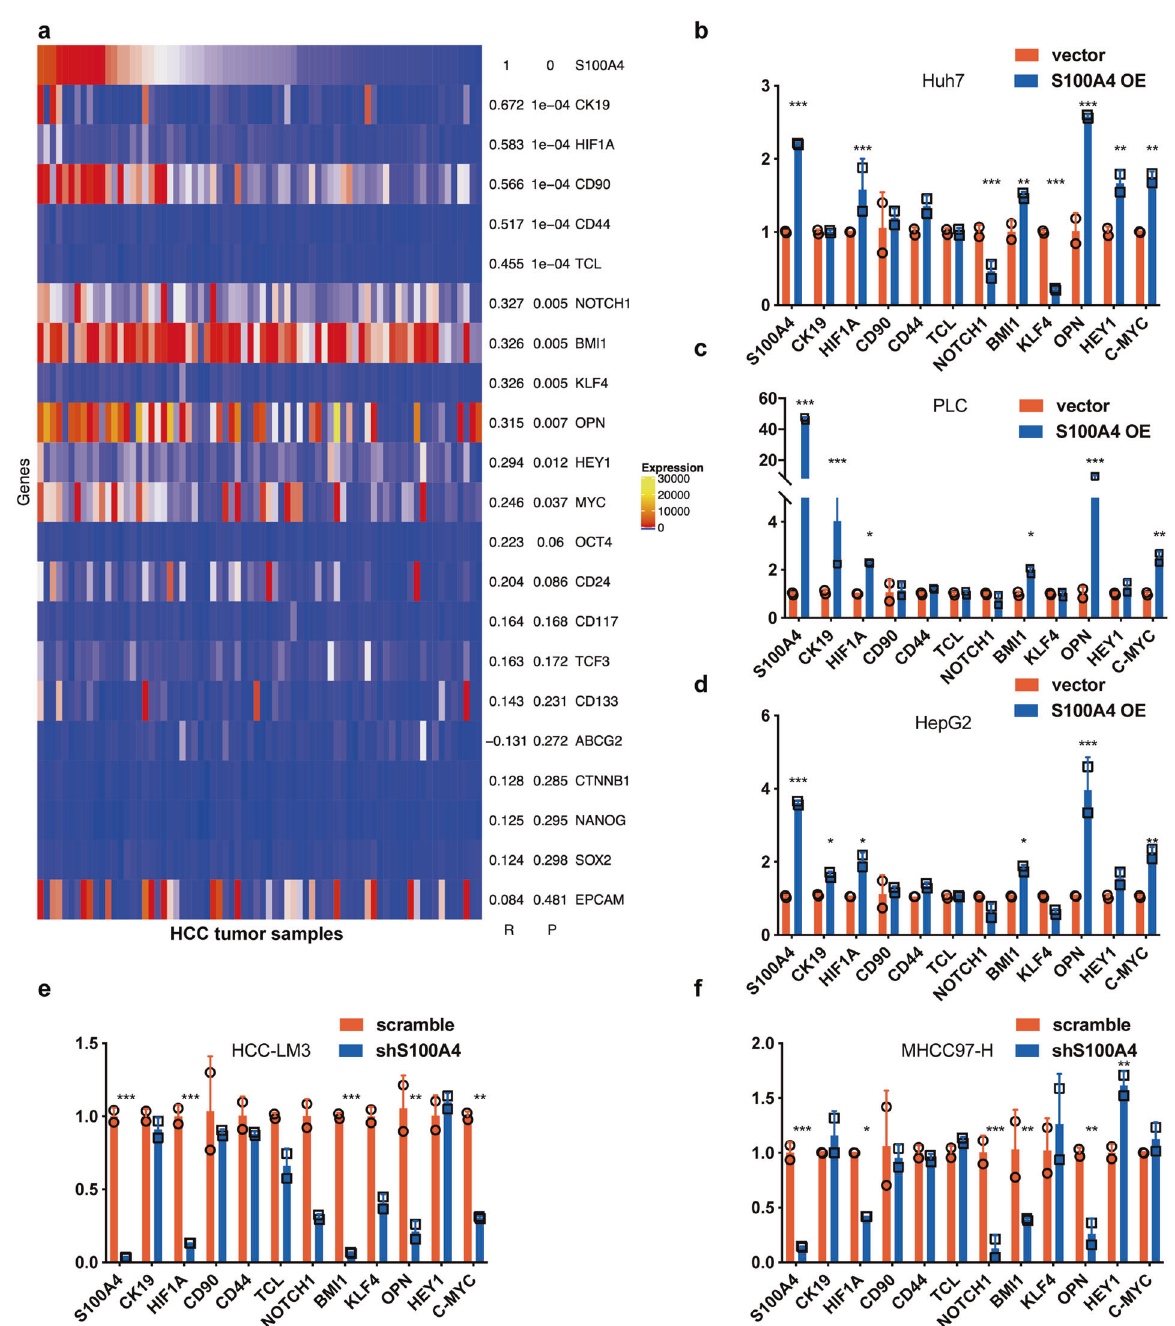
Fig. 4 S100A4 expression positively correlates with OPN. a Correlation between S100A4 and stemness-related genes. The GEO datasheet GSE39791 were used for correlation analyzes. Among the selected genes, 11 genes including OPN showed signi fi cant positive correlation with S100A4. Real-time PCR analyzes revealed the change of mRNA expression after S100A4 overexpression in low metastatic HCC cell lines, Huh7 ( b ), PLC ( c ), and HepG2 ( d ). In highly metastatic HCC cell lines, HCC-LM3 ( d ) and MHCC97-H ( f ), with S100A4 knockdown. Only OPN and its downstream genes (HIF1 and BMI1) in accordance with the tendency of S100A4 expression after knockdown and overexpression. Real-time PCR was conducted three times with two repetitions, and the dots represent the value of repetitions in one experiment. Error bars represent the mean ± SD; * P < 0.05, ** P < 0.01, *** P < 0.001, **** P < 0.0001 patients than non-metastatic ones (Supplementary Fig. S7c). levels of exosomal S100A4, CD63 and CD9 for feasibility Then we determined the plasma exosomal S100A4 and OPN veri fi cation by Western blot in 4 HCC patients (Supplementary levels by ELISA assay, and found a signi fi cantly positive Fig. S7a). We also tested plasma exosomal S100A4 in 10 HCC correlation between the exosomal S100A4 and OPN levels patients and 10 healthy donors. The exosomal S100A4 was (Fig. 6b). Based on the median value of exosomal S100A4 signi fi cantly higher in HCC patients (Supplementary Fig. S7b). (98.54 pg/ml) and OPN level (103.78 ng/ml), these patients were Exosomal S100A4 was signi fi cantly higher in metastatic HCC